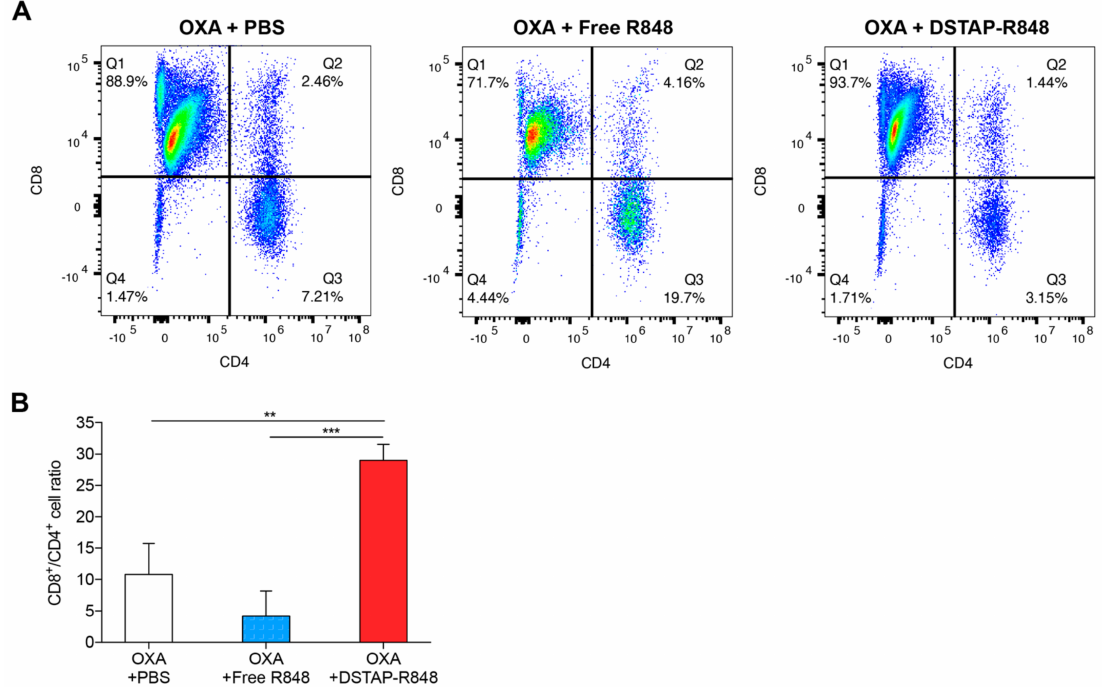
Figure 5. Change in CD4+ and CD8+ T-cell population in the peritoneal fluid after different treatments. ( A ) Representative flow cytometry plots showing the T-cell profiles. ( B ) Summary of CD8/CD4 ratio in each treatment group (data = mean ± SD, n = 3). **: p < 0.01, ***: p < 0.001, n.s.: no